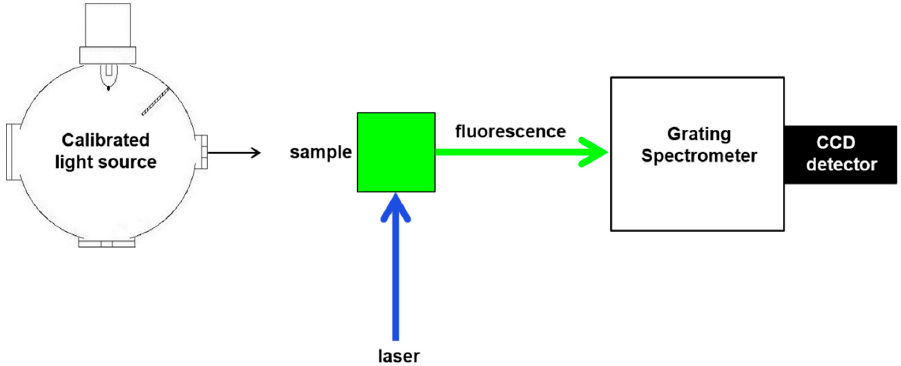
Figure 1. Schematic of the fluorescence spectrometer, with charge-coupled device (CCD) detector, used for the assignment of fluorescence intensities to calibration bead suspensions in equivalent reference fluorophore (ERF) units. The spectrometer was spectrally corrected for relative intensity of emission using a calibrated light source.